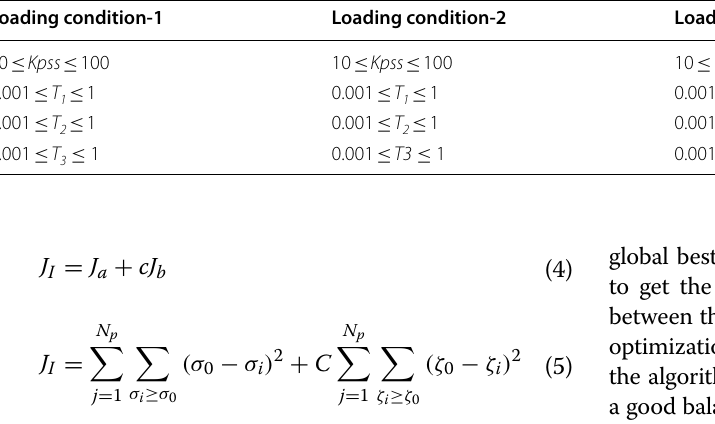
Table 2 Ranges of control parameters to be evolved Loading